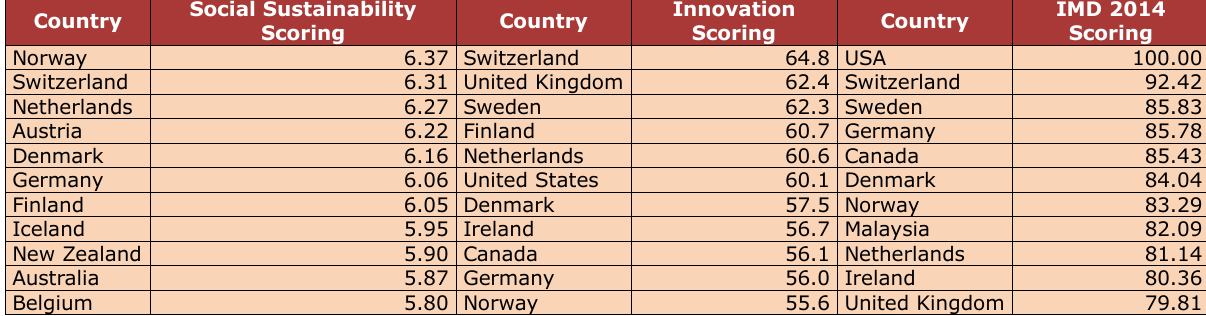
Table 3. Top Ten Countries of the 3 Performance